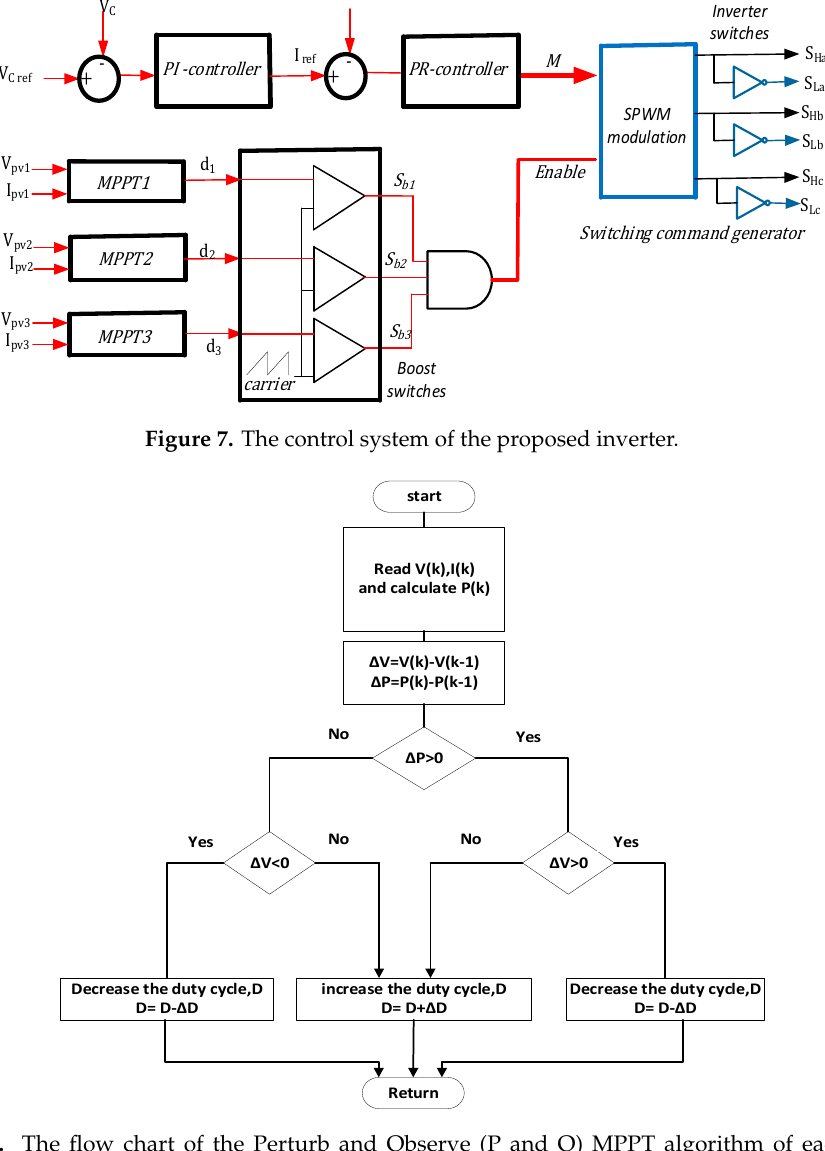
Figure 8. The flow chart of the Perturb and Observe (P and O) MPPT algorithm of each input operating independently.